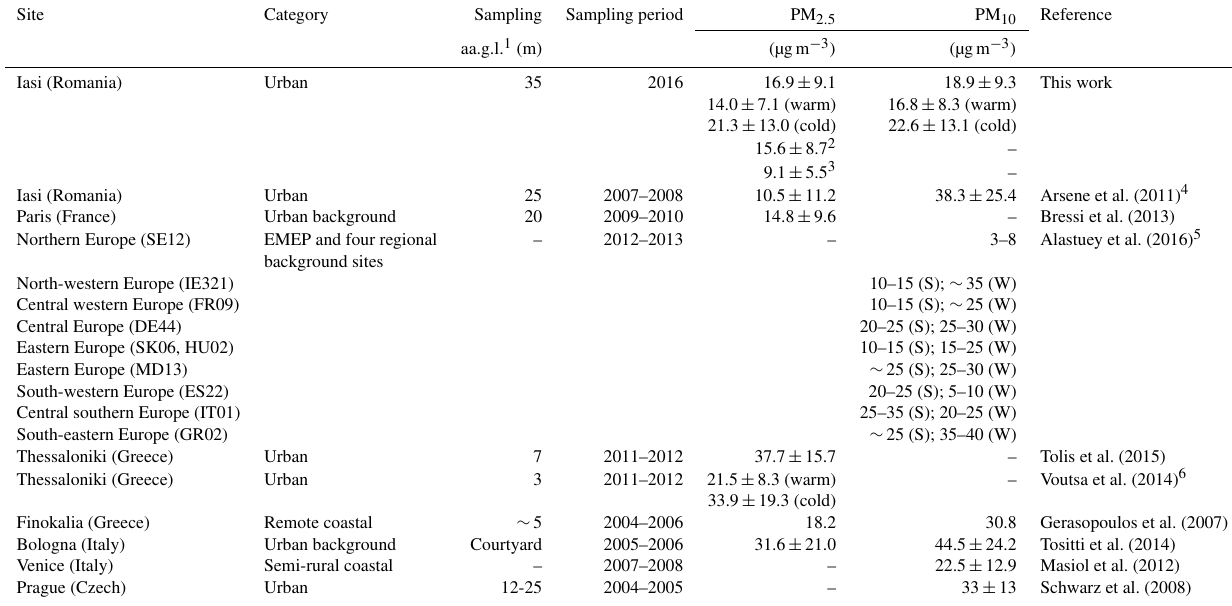
Table 2. Annual and/or seasonal arithmetic means of the PM 10 and PM 2 . 5 fraction mass concentrations in Iasi, north-eastern Romania, and other various European sites (mean ± SD).